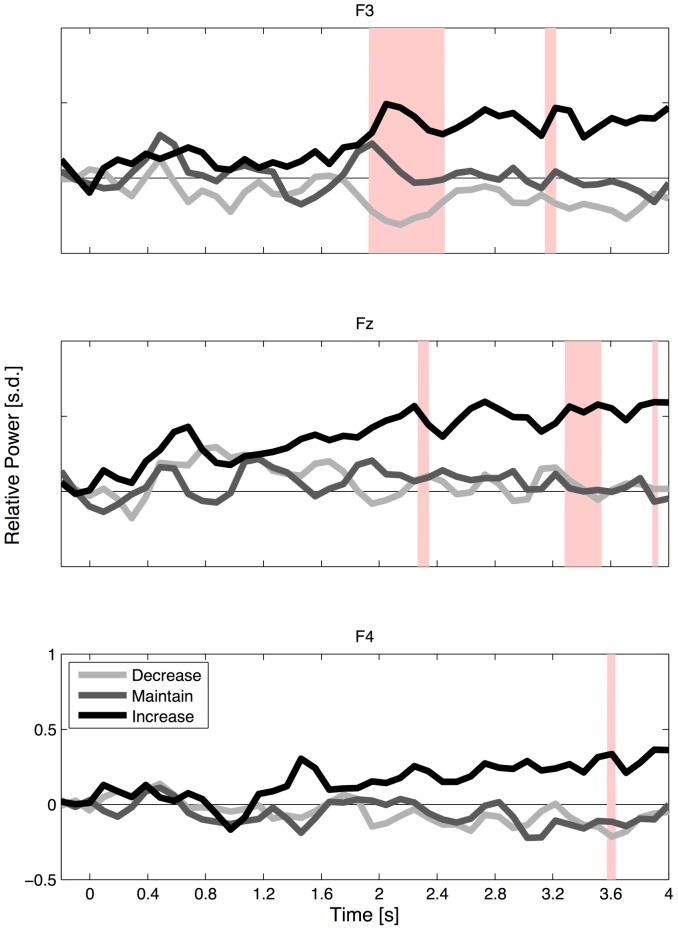
Temporal changes in frontal gamma power.Time-varying gamma activity at the left (F3, top), mid (Fz, mid), and right (F4, bottom) frontal regions during the cognitive reappraisal tasks. Lines indicate the decrease (light gray), maintain (dark gray), and increase (black) conditions. The light red areas in each panel indicate the significant difference durations (p<0.01).